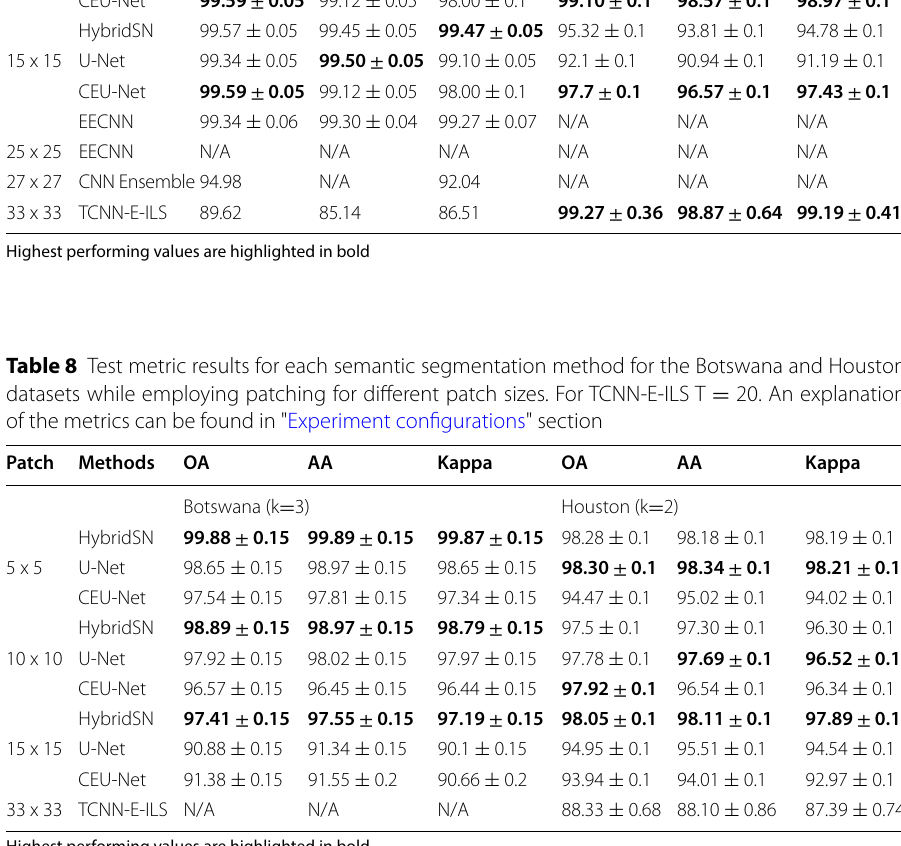
Highest performing values are highlighted in bold